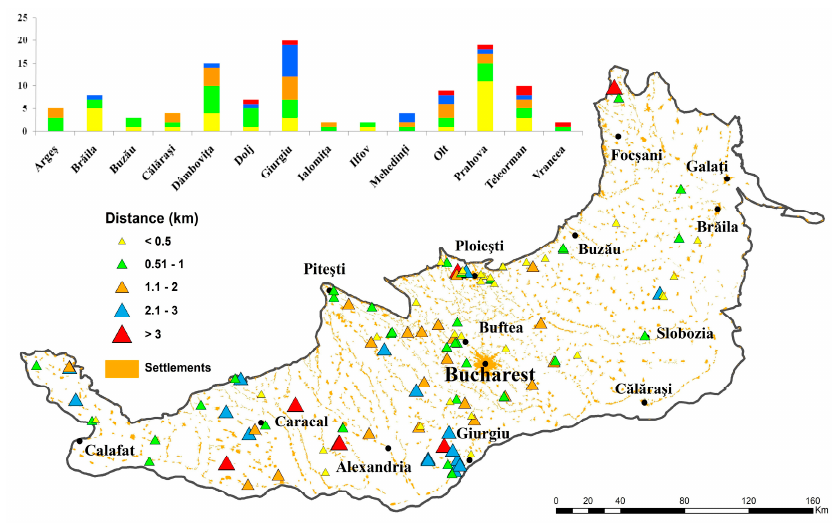
Figure 12. Distance of PV farms to settlements.